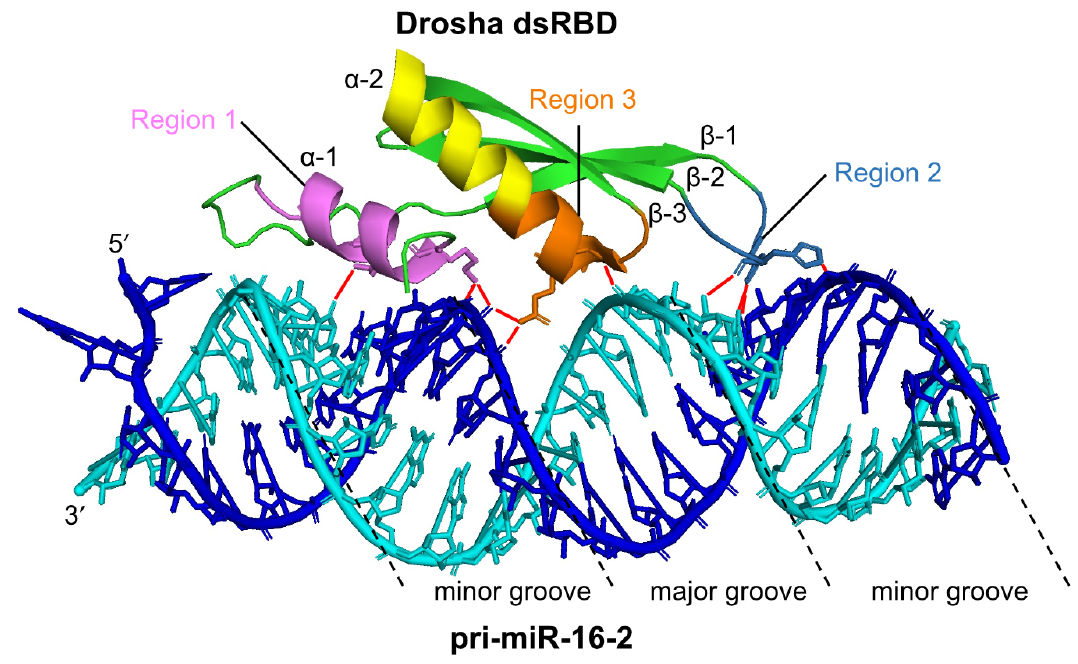
Figure 3. The structure of human Drosha dsRBD interacting with pri-miR-16-2. The dsRBD binds to the stem region of pri-miRNA via three regions (Region 1: violet, Region 2: sky-blue, Region 3: orange). A pri-miR-16-2 RNA strand is colored in blue, and the other RNA strand is colored in cyan. Red lines indicate the interaction sites between Drosha dsRBD and pri-miR-16-2. This figure is modified from the report produced by Partin et al. [52] (Protein Data Bank ID: 6V5B) using PyMOL (The PyMOL Molecular Graphics System, Version 2.0 Schrödinger,